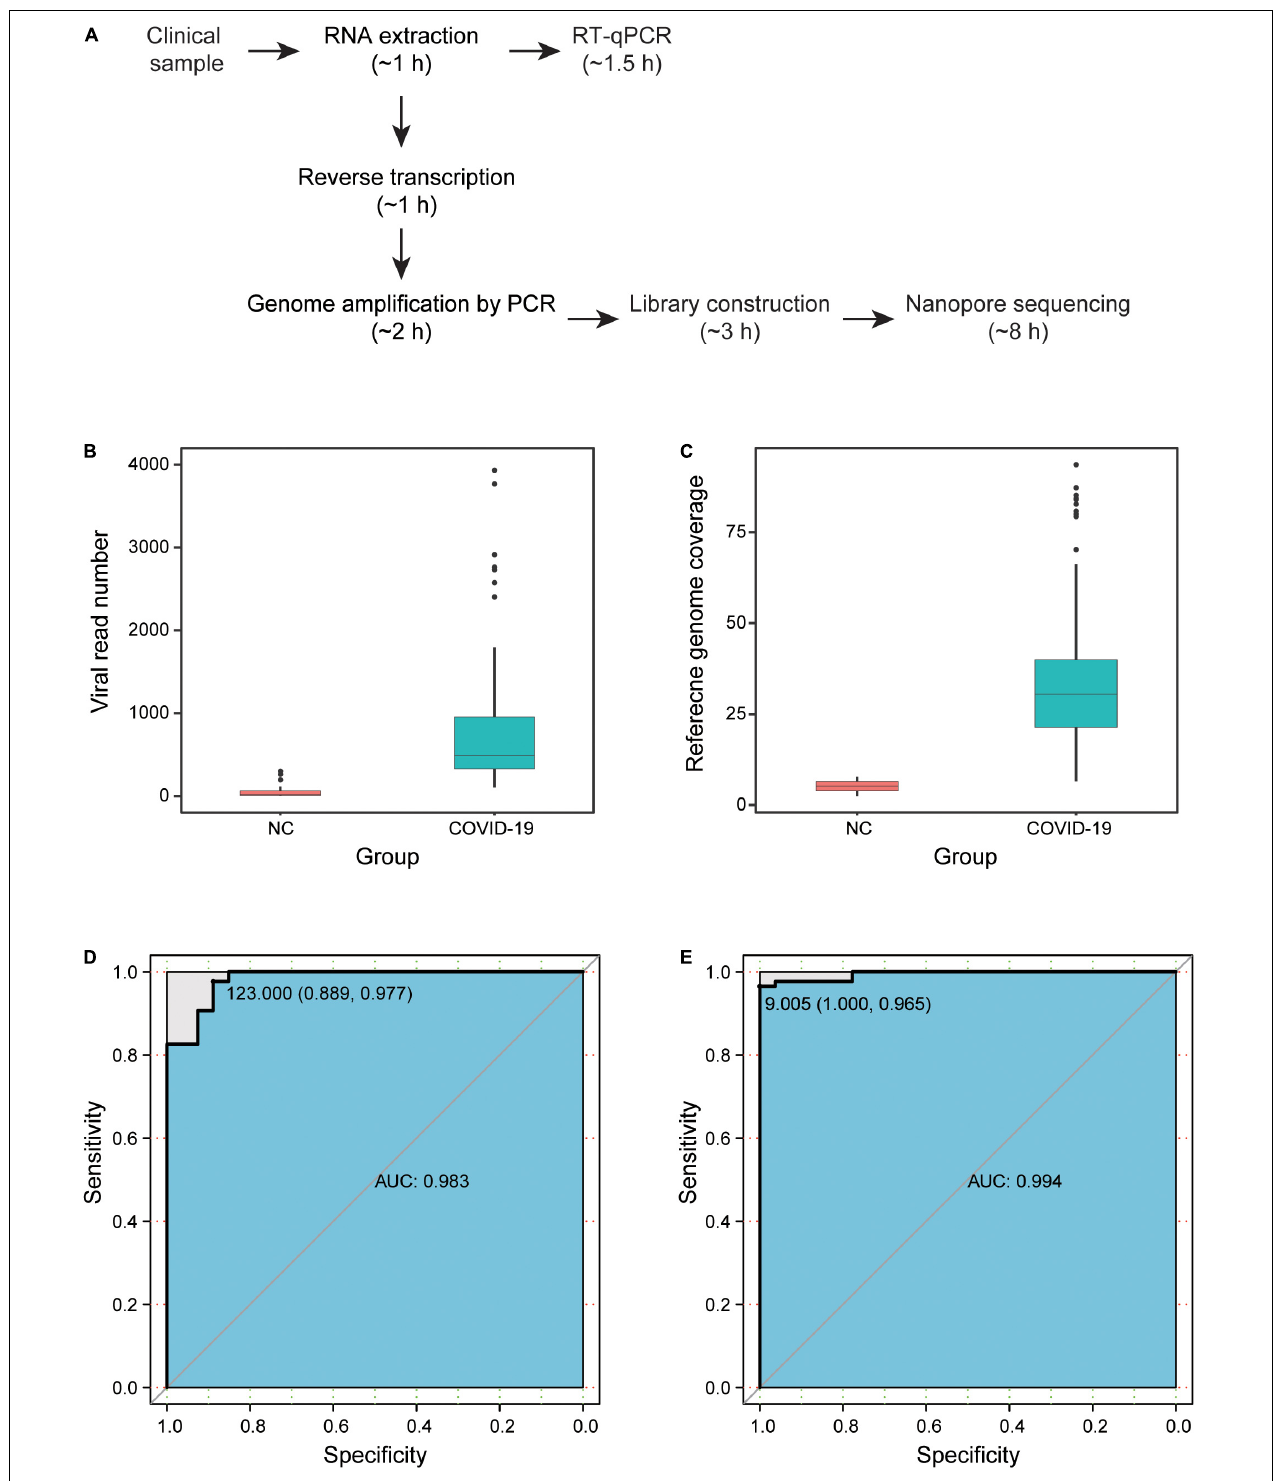
FIGURE 1 | Results of severe acute respiratory syndrome coronavirus 2 (SARS-CoV-2) NAS. (A) Detection time of NAS and RT-qPCR. (B) Viral read number of samples in the COVID-19 and NC groups. (C) Reference genome coverage of samples in the COVID-19 and NC groups. (D) ROC curve based on the viral read number. (E) ROC curve based on the reference genome coverage. NAS, nanopore amplicon sequencing; RT-qPCR, reverse transcription quantitative polymerase chain reaction; ROC, receiver operating characteristic; NC, negative controls; COVID-19, coronavirus disease 2019.